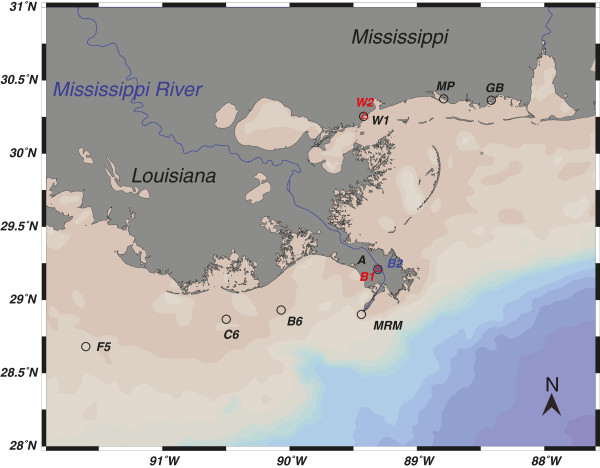
Sampling stations in the northern Gulf of Mexico. Stas. C6, CT, F5 and B6 were from marine shelf; Stas. Waveland H, W1, GB, and MP were from salt marsh; MRM from the Mississippi River mouth; A, B1, B2 were from estuarine freshwater marsh.